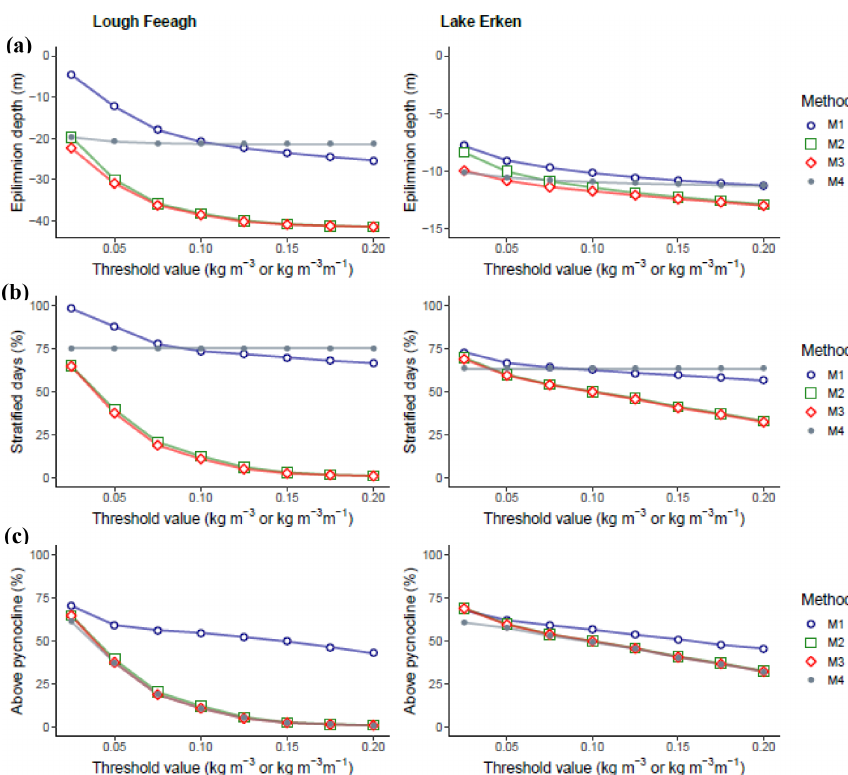
Figure 6. Mean April–October epilimnion depth (m) (a) ; percentage of stratified days, defined as days when the epilimnion depth was identified as shallower than the lake maximum measured depth (%) (where a larger percentage value indicated a higher occurrence of days identified as stratified) (b) ; and percentage of days when the epilimnion depth was above the pycnocline, defined as the number of days when the epilimnion was identified at a depth shallower than the maximum density gradient (where a larger percentage value indicated a lower occurrence of days erroneously extending into the metalimnion) (c) for Lough Feeagh and Erken